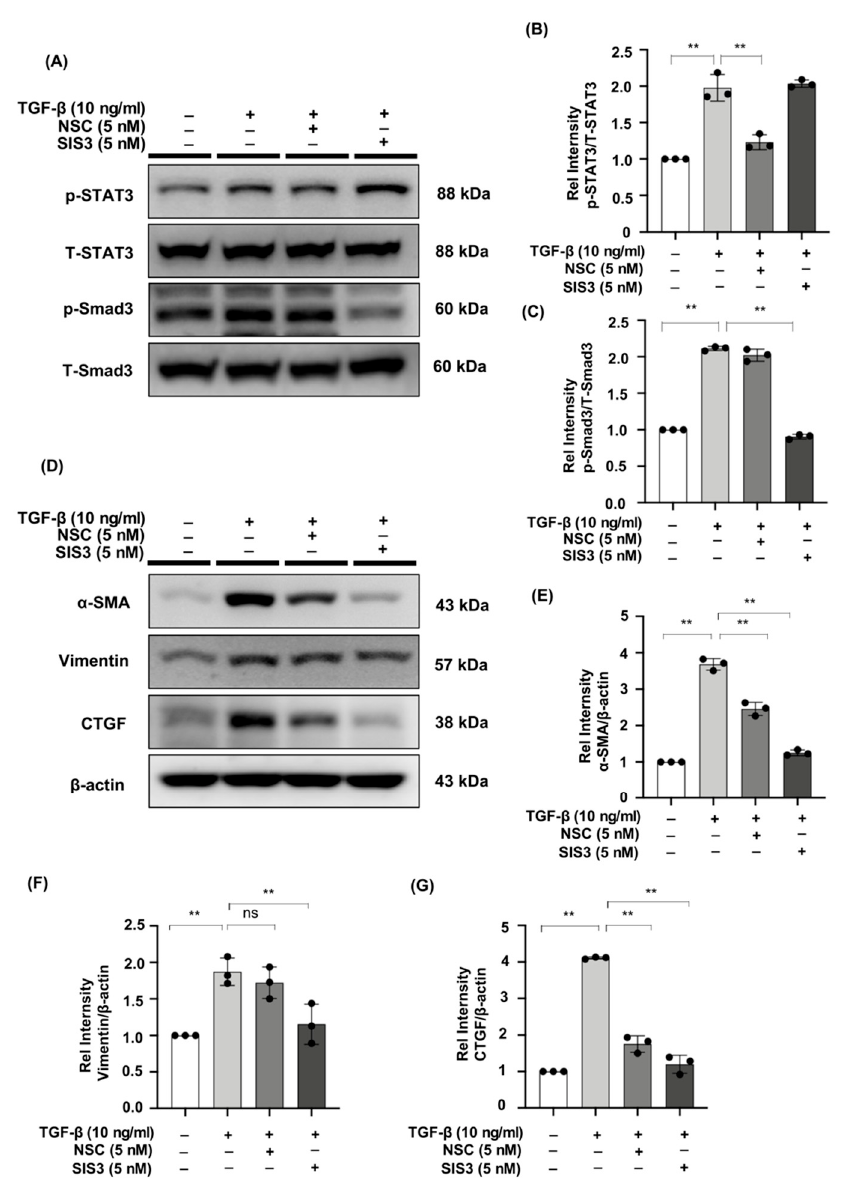
Figure 6. The STAT3 inhibitor, NSC, and the Smad3 inhibitor, SIS3, reduced the expression of fibrotic markers in TGF- β -stimulated NRK49F cells. ( A ) Expression of p-STAT3, T-STAT3, p-Smad3, and T-Smad3 in TGF- β -treated NRK49F cells with treatment of NSC and SIS3 was detected by western blot and quantified by densitometry. Cells were pre-treated with NSC and SIS3 for 2 h after starvation with 0.5% FBS medium and then treated with TGF- β (10 ng/mL) for 30 min. ( B , C ) Statistical significance was presented as the mean ± SD, n = 3. ** p < 0.01, ns: no significance. ( D ) Western blot demonstrated that NSC and SIS3 decreased the protein expression of α -SMA, vimentin, and CTGF in TGF- β stimulated NRK49F cells. NRK49F cells were treated with NSC or SIS3 for 2 h and then treated with TGF- β (10 ng/mL) for 30 min and incubated in a 5% FBS medium for 24 h. ( E – G ) Statistical significance was presented as the mean ± SD, n = 3. ** p < 0.01, ns: no